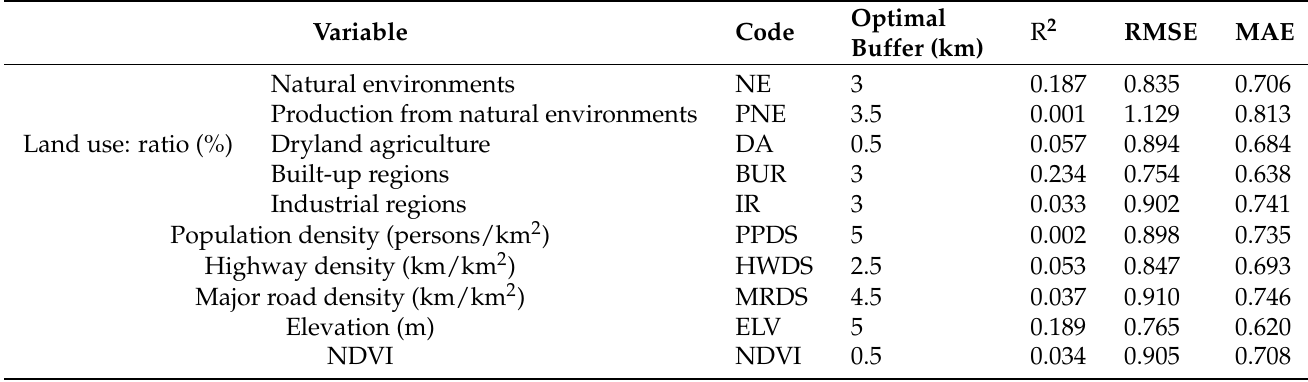
Table 2. Goodness-of-fit and errors of land use regression (LUR) models for selected individual explanatory variables. The unit of RMSE and MAE is µ g/m 3